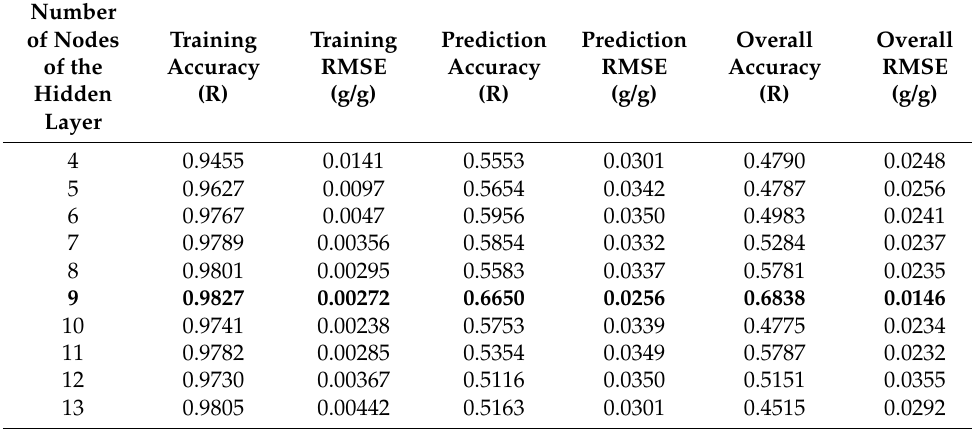
Table 2. Erf-BP neural network model using multiple remote-sensing